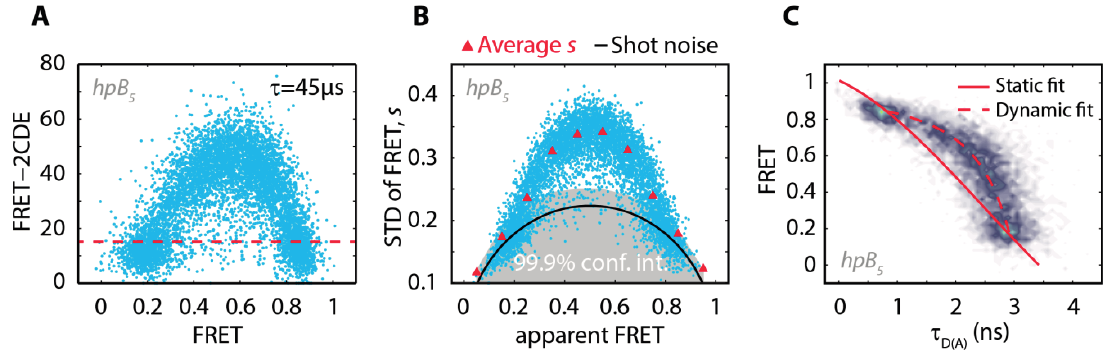
Figure 2. ( A ) Scatter plot of FRET-2CDE vs. FRET for the DNA hairpin construct hpB . 5 The FRET-2CDE value ( τ = 45 μ s, kernel time constant) was calculated for every burst. Well-defined closed and opened conformations were selected by the analysis of bursts with a FRET-2CDE value below 15 (threshold indicated by red dashed line); ( B ) An equivalent method is the Burst variance analysis (BVA). Static, well-defined open or closed species can be found at the shot noise line (black line) within the confidence interval of 99.9% for the DNA hairpin construct hpB . The displaced stream (grey); ( C ) FRET vs. τ D(A) 5 between the two FRET states shows that the mid-population in Figure 1G originates from fast interconverting